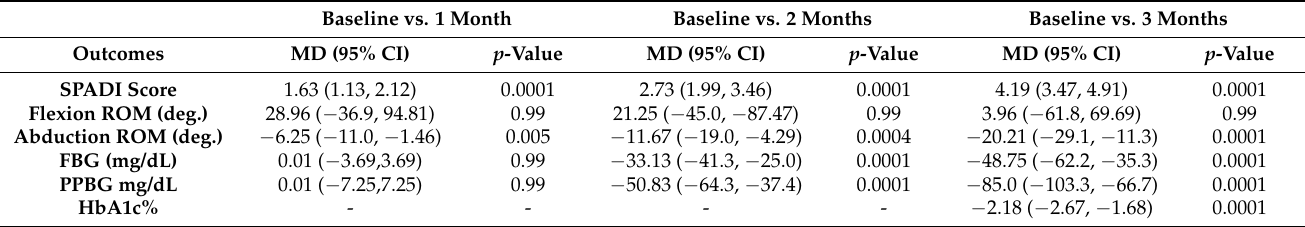
Table 3. Pairwise Comparisons for Group A Pretreament, after 1 Month, 2 Months and 3 Months *. Baseline vs. 1 Month Baseline vs. 2 Months Baseline vs. 3 Months